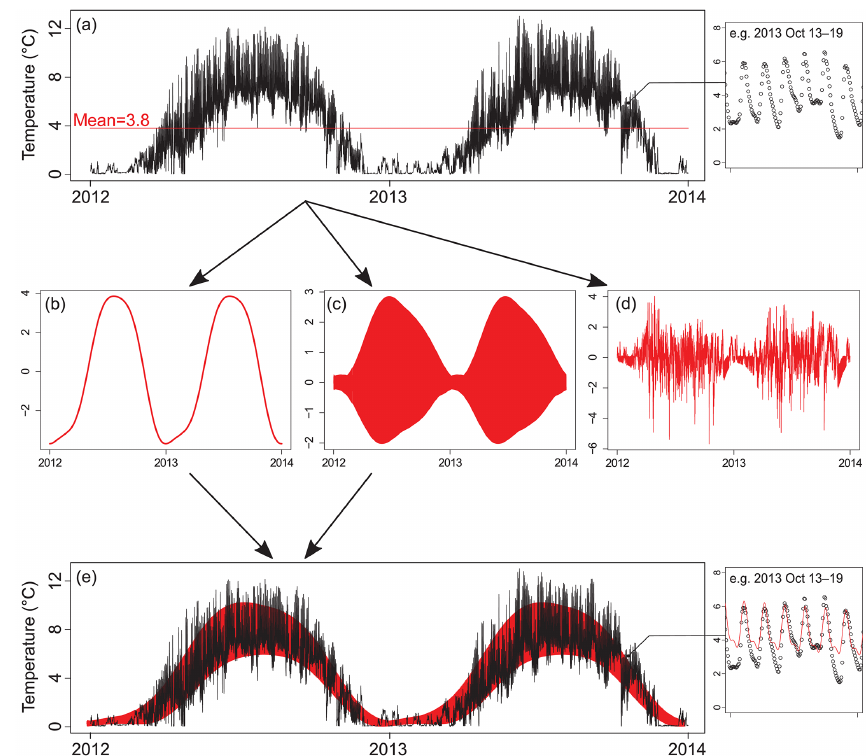
Figure 2. Hourly time series temperature at the reference site decomposed using Fourier decomposition analysis. (a) The observed record T a in 2012–2013 is decomposed into an average value (a) , seasonal periodicity pattern S a (b) , diel periodicity pattern D a (c) , and the irregularity ε a (d) . The comparison between the observed and measured temperature excluding ε a at the reference site (e)